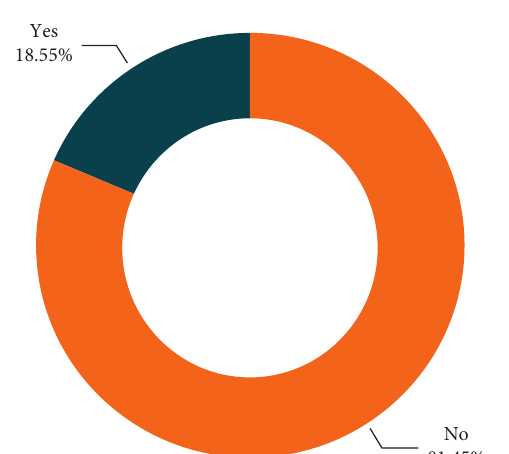
Figure 10: Distance exam.